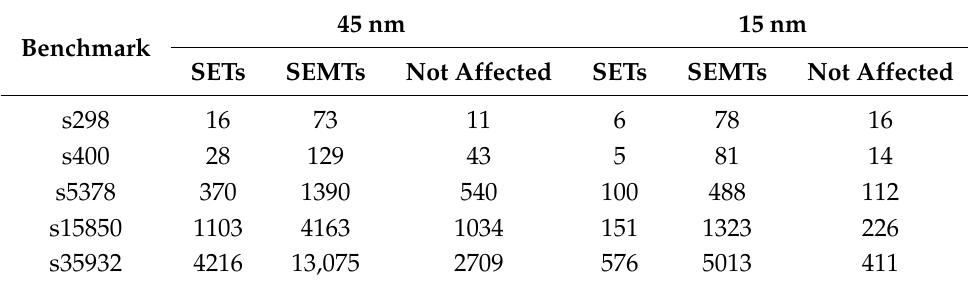
Table 6. Distribution of SETs, SEMTs, and unaffected gates by particle strikes.